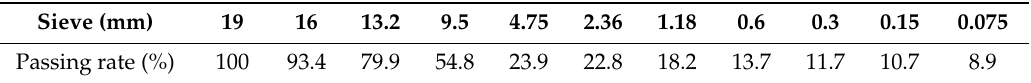
Table 3. Design Synthesis Grading of